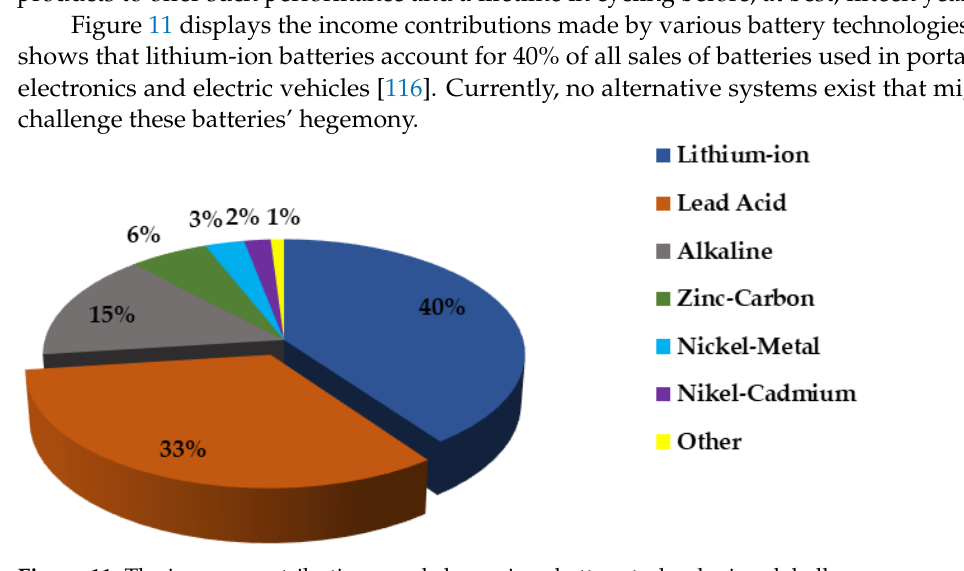
Figure 12. Life and efficiency comparison of different battery technologies. 4.3. Batteries for Electricity Storage All the just-described systems with the highest energy densities are essential for transportation. In stationary applications, such as the bulk storage of power from renew- able energies or the electrification of dwellings, the criteria for selection are entirely